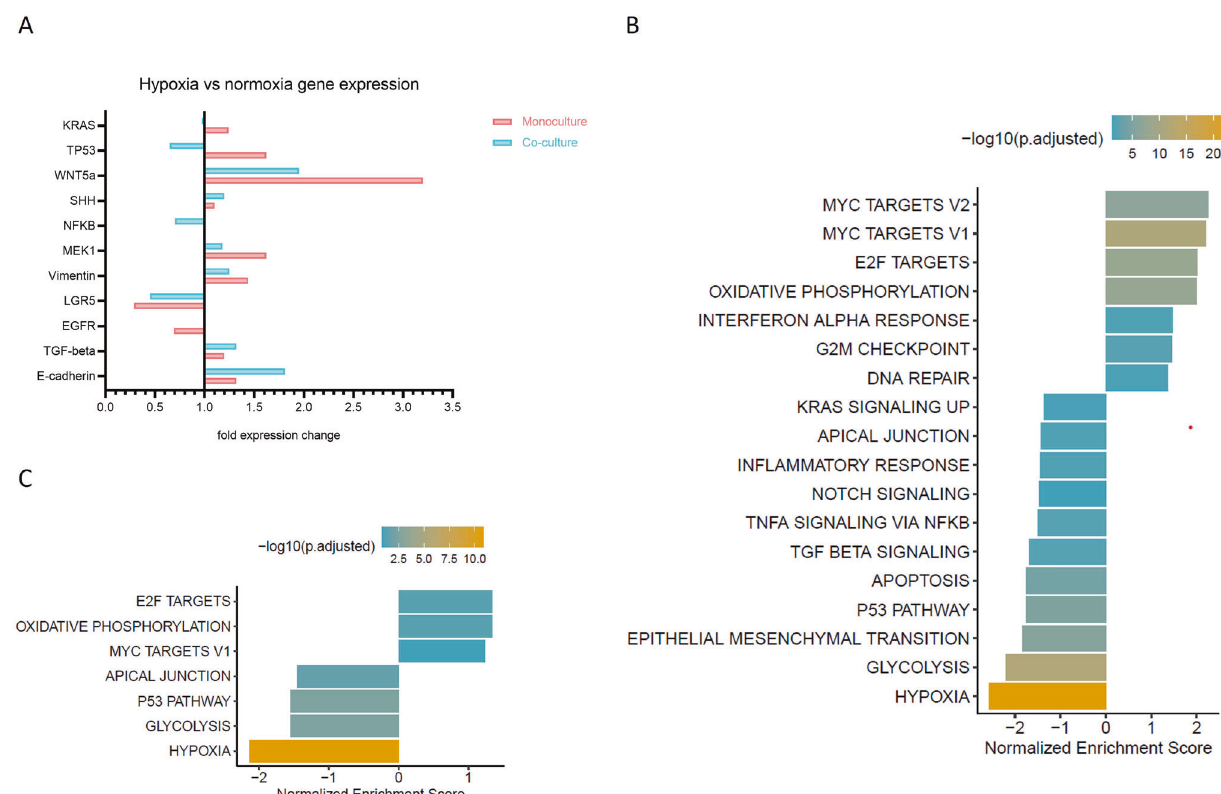
Fig. 3 Hypoxia in fl uences the transcriptional state of PDAC organoids (co-)cultures. Cells were grown under 1% O 2 or 20% O 2 , for 4 days until harvested for RNA isolation, cDNA synthesis and qPCR. A Gene expression analysis of cells grown in hypoxia vs. normoxia. Fold expression changes in normoxia and hypoxia in monoculture and co-culture. The values were normalized to β -actin expression and to normoxic culture conditions to determine the expression differences in hypoxia. ( N = 3, 24 chips were pooled for each sample) B RNA Sequencing data of PDAC organoids grown in normoxia and hypoxia. The data is depicted with the Hallmark database and shows pathways upregulated in normoxia (above 0) and pathways upregulated in hypoxia (below 0). The color indicates the -log10(p.adjusted) ( N = 1, 48 chips were pooled for each sample). C RNA-Sequencing data of PDAC organoids in co-culture with PSCs grown in normoxia and hypoxia. The data is depicted with the Hallmark database and shows pathways upregulated in normoxia (above 0) and pathways upregulated in hypoxia (below 0). The color indicates the -log10 (p.adjusted). ( N = 1, 48 chips were pooled for each sample). Pathways with P < 0.05 are depicted. The graph with all up-, and downregulated genes are depicted in Fig. (Table S3). Drug exposure was performed under normoxic and hypoxic conditions. Drugs were divided into two groups according to the type of response observed in mono- or co-cultures. Group A is composed by Gemcitabine and combinatorial treatment with Syrosingopine, Metformin and Erlotinib (Fig. 4). These compounds were more